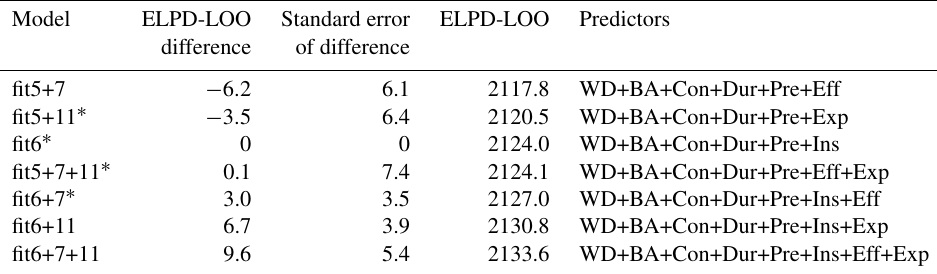
Table 5. Comparison of flood-type model candidates by their difference in ELPD-LOO using combinations of the first five predictors (fit5) plus predictors 6, 7, and 11, along with their differences and the standard error of the differences with reference to candidate model “fit5+6” (see Table S3 for all model variants).